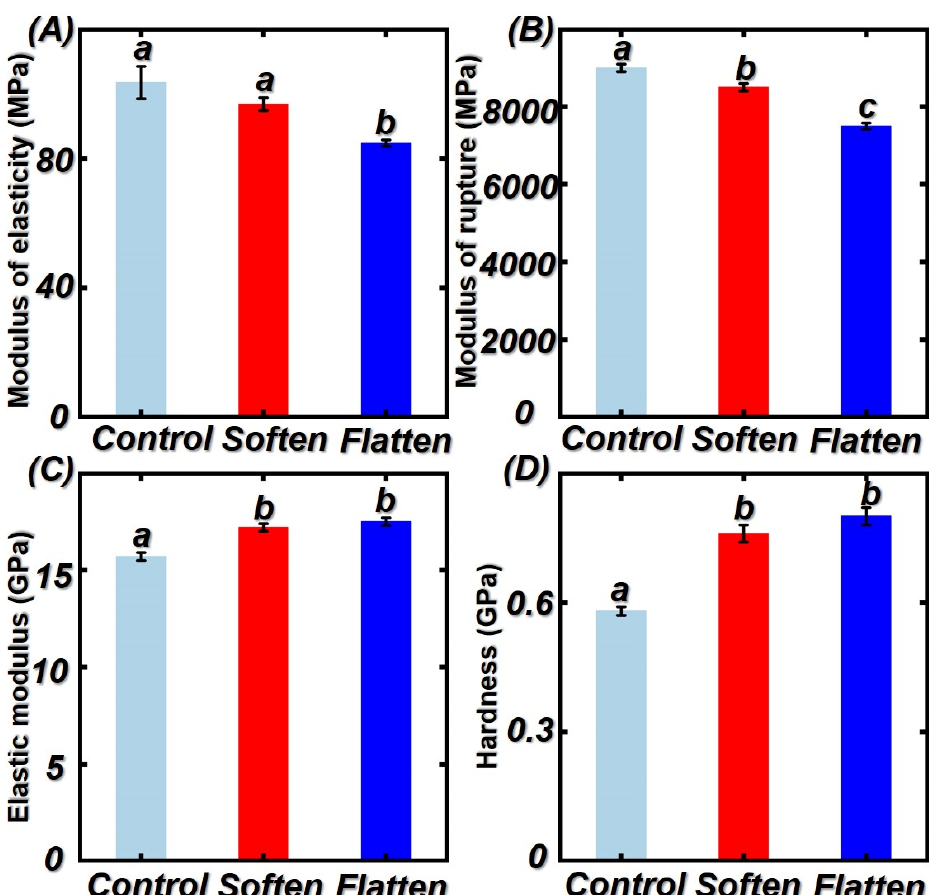
Figure 7. Mechanical properties of control, softened treated, and flattened bamboo samples at 180 degrees and 8 min: ( A ) modulus of elasticity; ( B ) modulus of rupture; ( C ) elastic modulus of bamboo cell walls; ( D ) hardness of bamboo cell walls. Different capital letters represents the significant difference between heat treatment groups ( p < 0.05). The error bar in the picture represents the standard deviation.